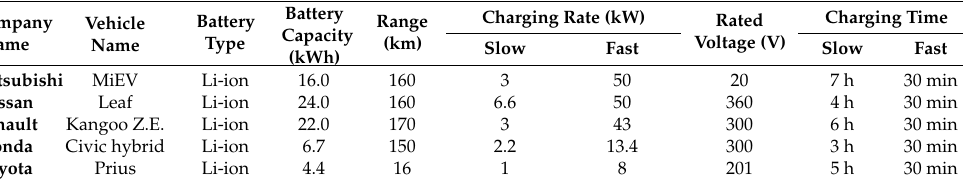
Table 2. PHEVs technical details [45–49].